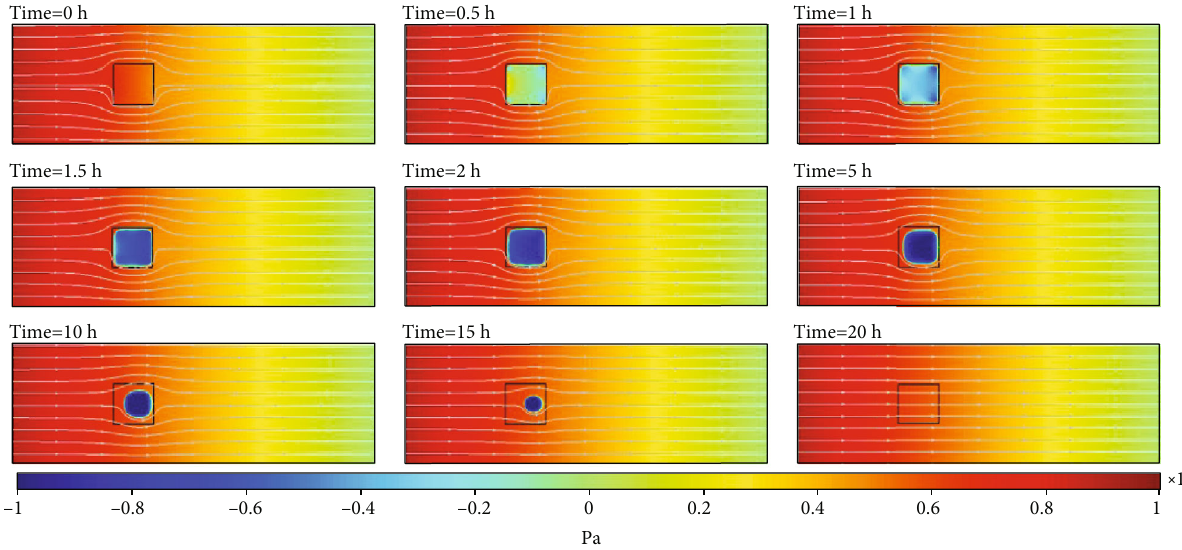
Figure 7: Pressure distribution. Display the variation of pressure distribution in the thawing